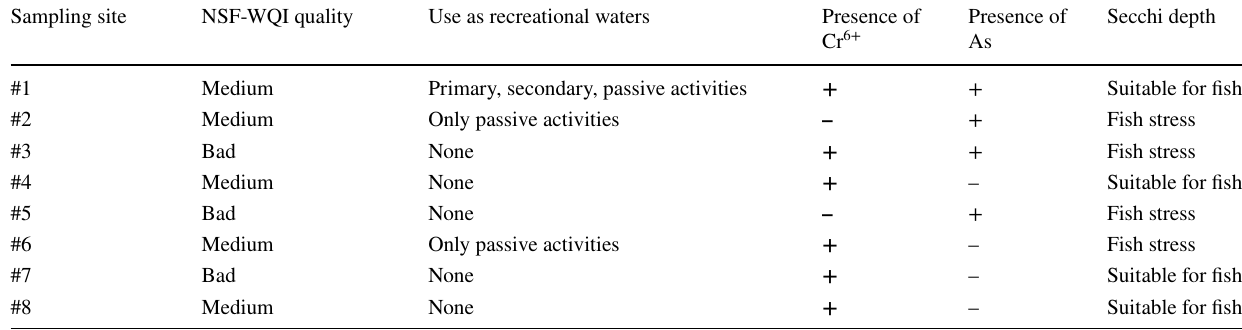
Table 10 Summary of results Sampling